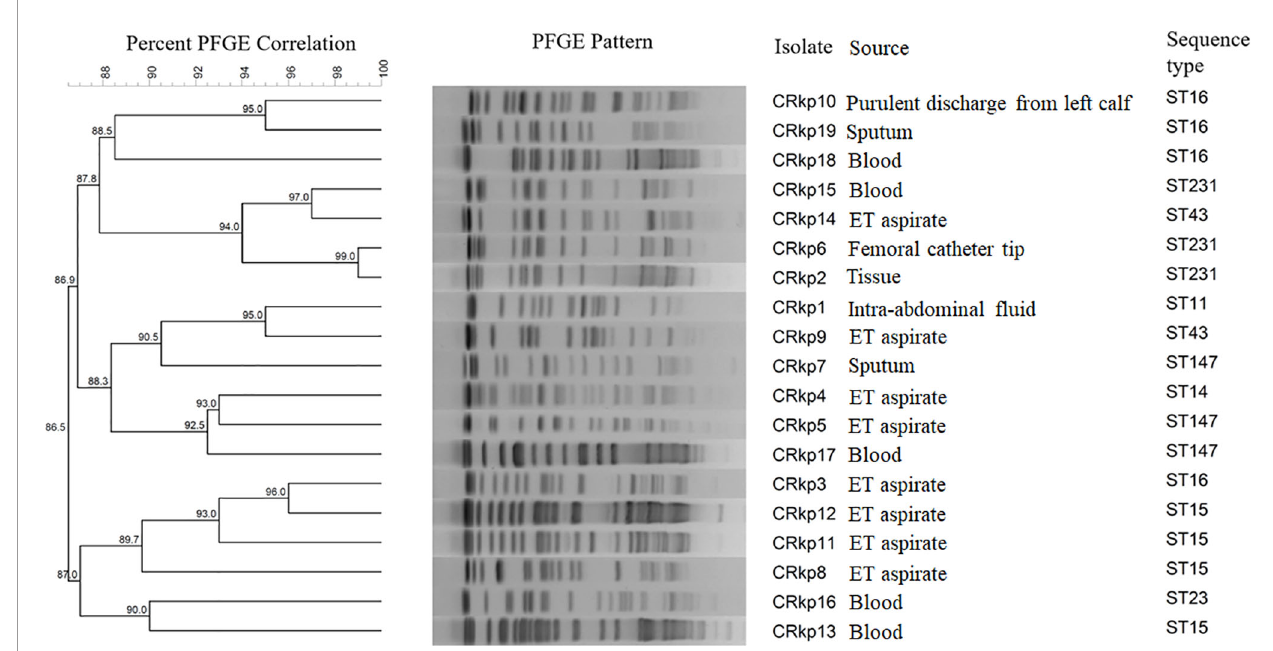
FIGURE 1 | A dendrogram of the pulsed- fi eld gel electrophoresis (PFGE) fi ngerprinting results and sequence types of 19 mcr-1 positive Klebsiella pneumoniae